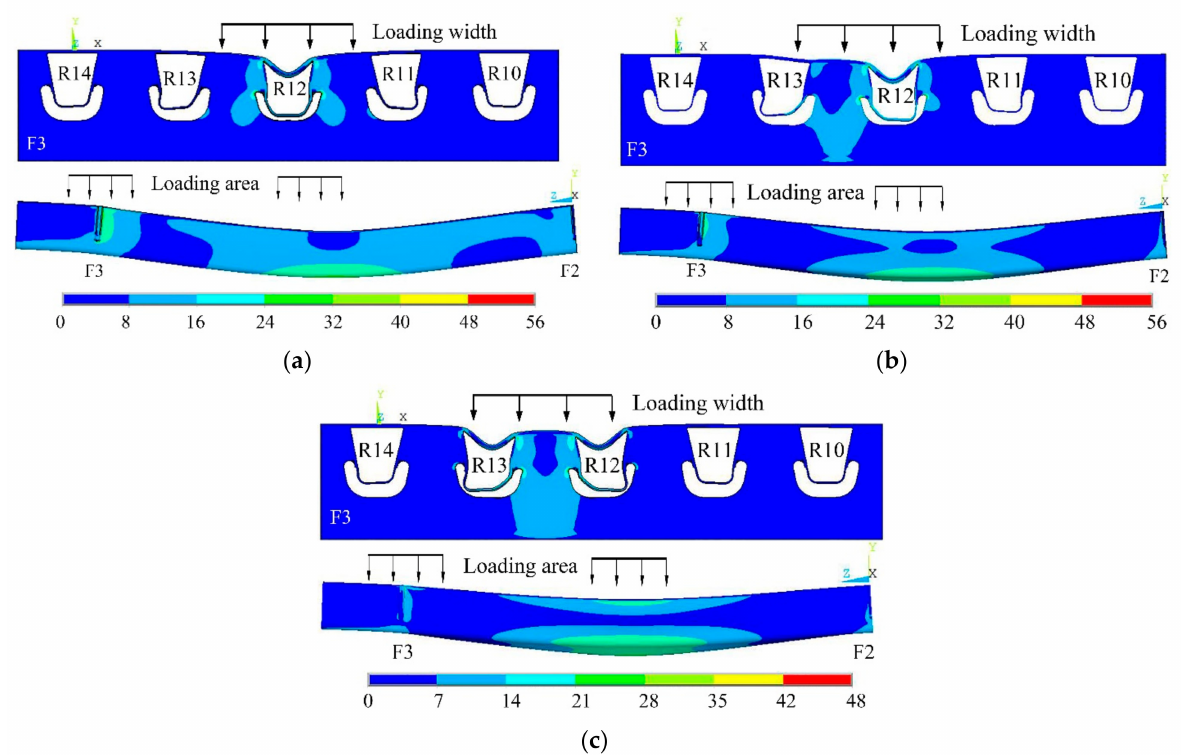
Figure 19. Stress contour plots and deformation of F3 and R12. ( a ) LC1; ( b ) LC2; ( c ) LC3. (Unit: